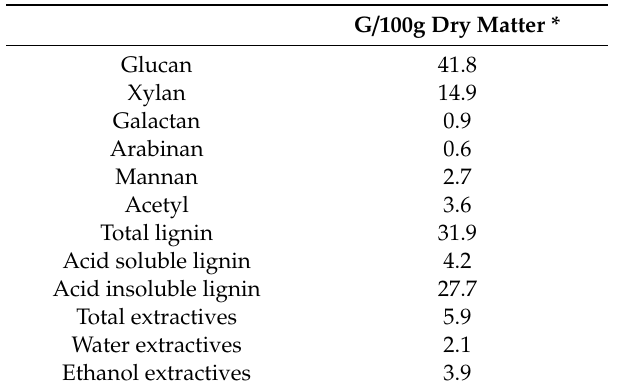
Table 1. Chemical composition of poplar sawdust (PSD) raw